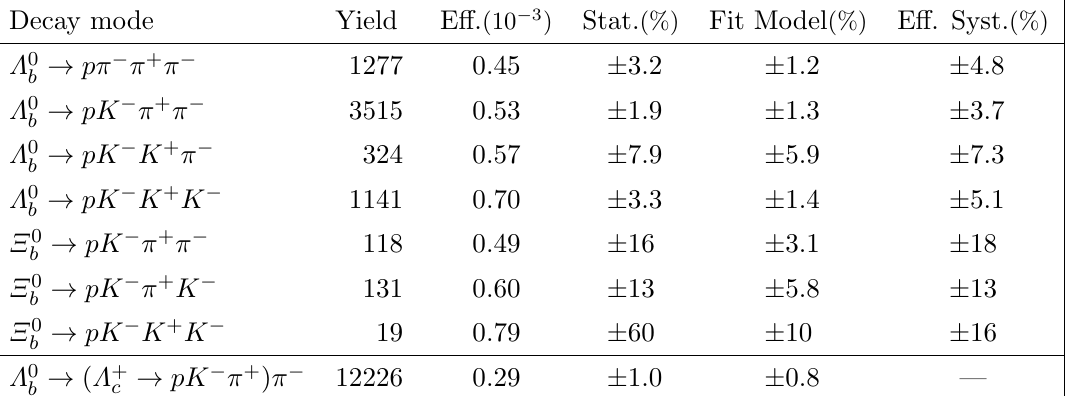
| Table 4 . Yields and e(cid:14)ciencies of each signal decay with the statistical uncertainty, and systematic uncertainties related to the (cid:12)t model and the e(cid:14)ciency determination, for the 2012 data samples. R (per decay) Value (%) (cid:1) Combination (%) 06.69 (cid:6) 0.33 (cid:6) 0.09 (cid:6) 0.37 R ( (cid:3) 0 ! p(cid:25) (cid:0) (cid:25) + (cid:25) (cid:0) ) (cid:0) 0 : 6 (cid:27) 06 : 85 (cid:6) 0 : 19 (cid:6) 0 : 08 (cid:6) 0 : 32 b